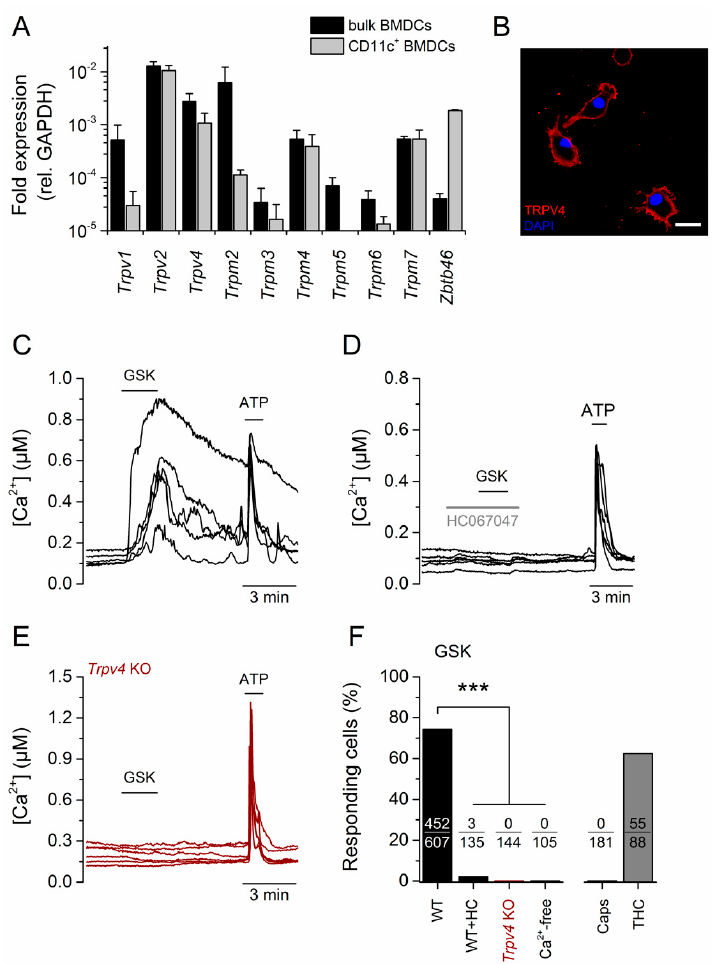
Figure 1. TRPV4 was functionally expressed in CD11c + bone marrow-derived cells (BMDCs). ( A ) Expression profile of selected Trp genes in the total granulocyte-macrophage colony-stimulating (GM-CSF)-differentiated bone marrow-derived cell population (black bars) and in CD11c + -purified BMDCs (light gray). Values are relative to GAPDH expression. ( B ) Confocal image of CD11c + BMDCs stained with an anti-TRPV4 antibody (red). The blue color corresponds to nuclear staining with DAPI. ( C–E ) Representative traces of intracellular Ca 2 + concentration in CD11c + BMDCs showing the effects of 300 nM of GSK1016790A (GSK). ATP (100 µ M) was used as a positive control for intracellular Ca 2 + increase. The TRPV4 antagonist HC067047 was used at 10 µ M. ( F ) Percentage of CD11c + BMDCs responding to the indicated stimulus. GSK, GSK1016790A (300 nM); HC, HC067047 (1 µ M); Ca 2 + -free, Krebs with nominal [Ca 2 + ] supplemented with 2.5 mM EDTA; Caps, Capsaicin (1 nM); THC, trans- ∆ 9 -tetrahydrocannabinol (10 µ M). The responding fraction is indicated within each bar. ***, p < 0.001, Fisher’s exact